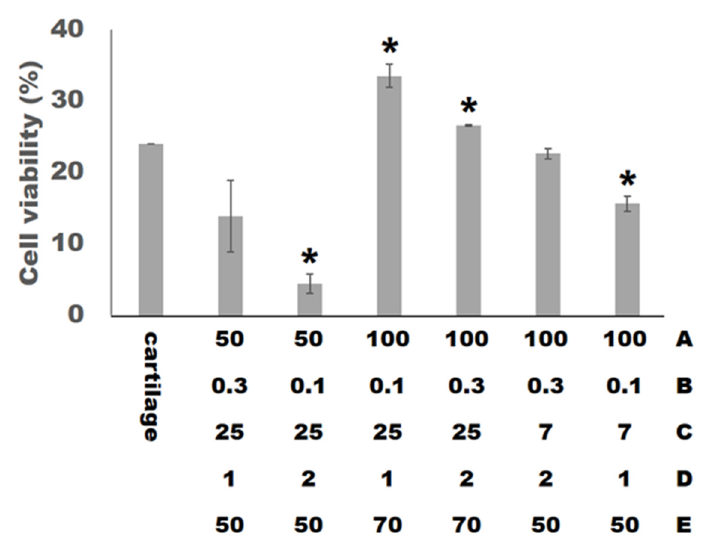
Figure 4. The Young’s modulus of the scaffolds compared with natural articular cartilage. The asterisk (*) indicates p < 0.05 versus cartilage. Table 5. ANOVA analysis of Young’s modulus. Source Sum of Squares Mean